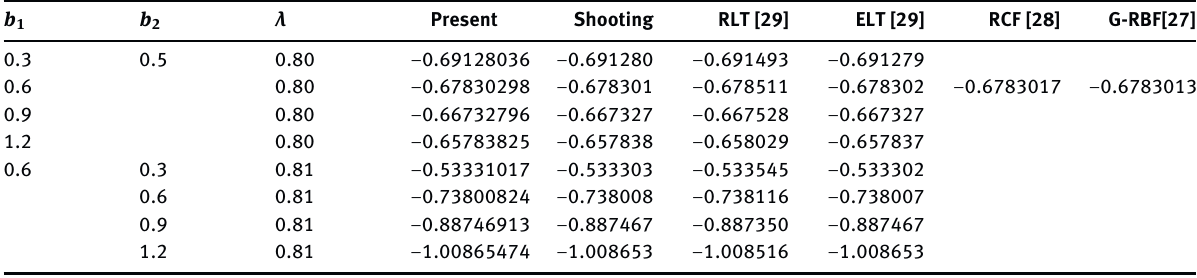
Table 4: Comparison of the obtained values of y ′ (0) for various values of b 1 and b 2 by the present method, shooting method, RLT, ELT, RCF, and G-RBF